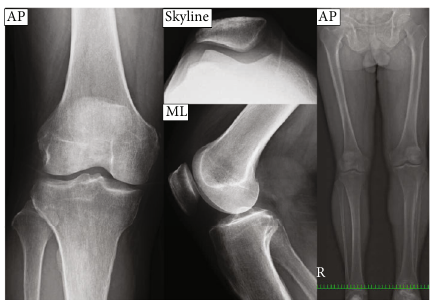
Figure 1: MRI showed a thickening of the medial plica protruding far into the medial patellofemoral joint (PFJ). Figure 2: Valgus knee and patellar instability appeared on a plane X-ray with a large Q angle: 17 ° , tilt angle: 21 ° , and lateral shift: 18%.